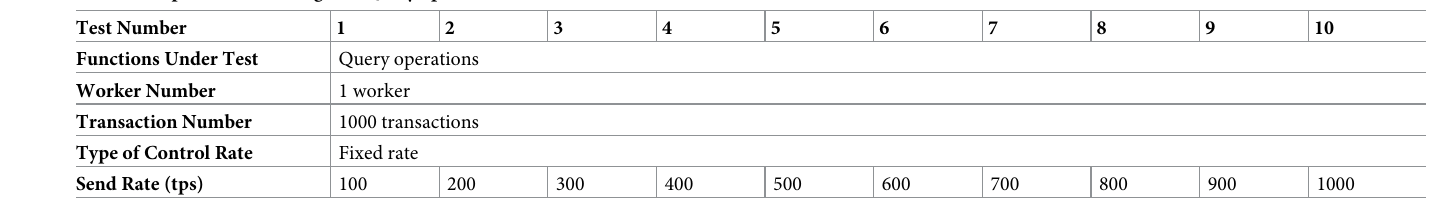
Table 5. Experimental settings for Query